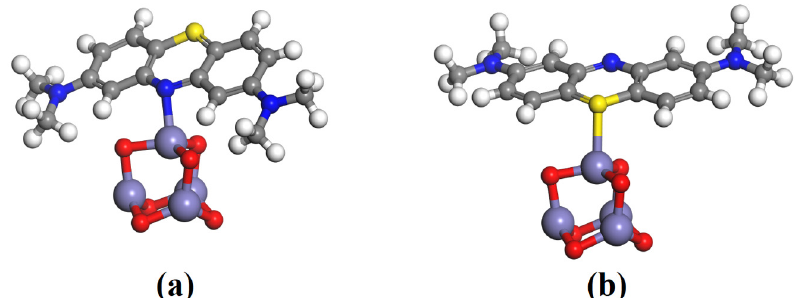
Figure 6. Optimized geometry of the MB adsorption over the Fe 2 O 3 NPs from the nitrogen site ( a ) and sulfur site ( b ). The white, grey, dark blue, red, yellow, and light blue colors represent hydrogen, carbon, nitrogen, oxygen, sulfur, and iron atom.